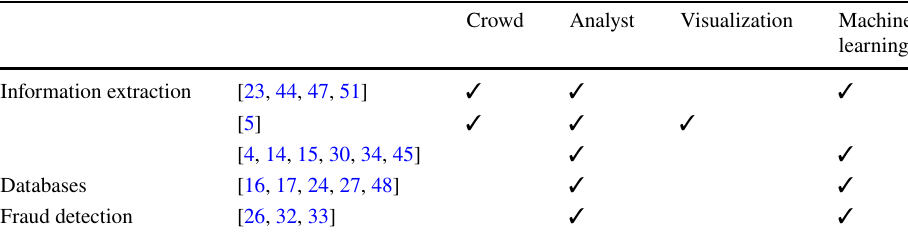
Table 1 A sample list of different rule adaptation techniques and their domains